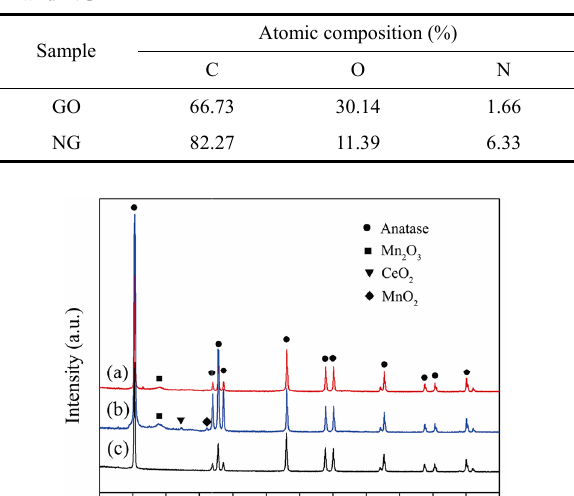
Table 1 C, N, O surface atomic concentrations of GO